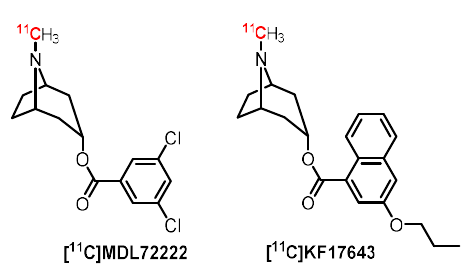
Figure 10. [ 11 C]MDL72222 and [ 11 C]KF17643 .